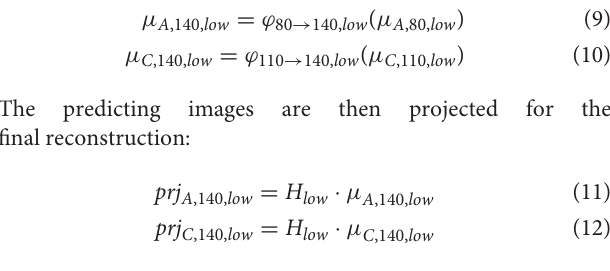
Reconstruction images µ ′ A ,80, low and µ ′ C ,110, low are used as